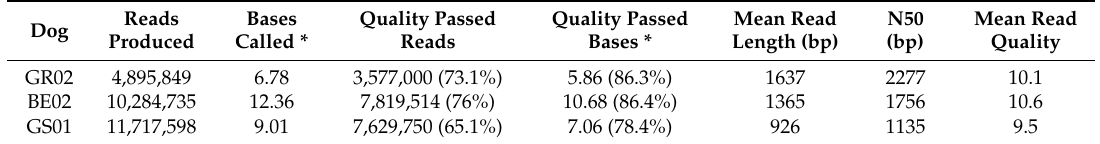
Table 1. Full-length cDNA sequencing (ONT).